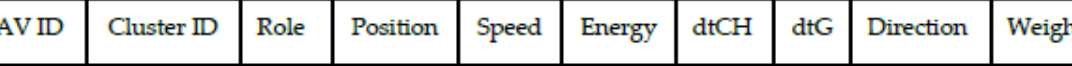
Figure 1. UAV clustering network structure.